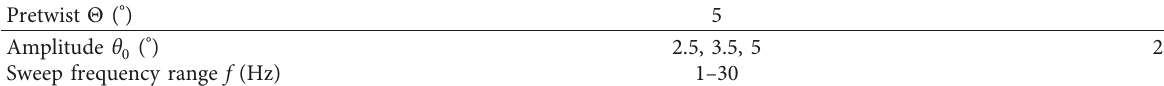
° . (a) Dynamic stiffness error k 0 (cid:31) 5 Table 5: Loading scheme.